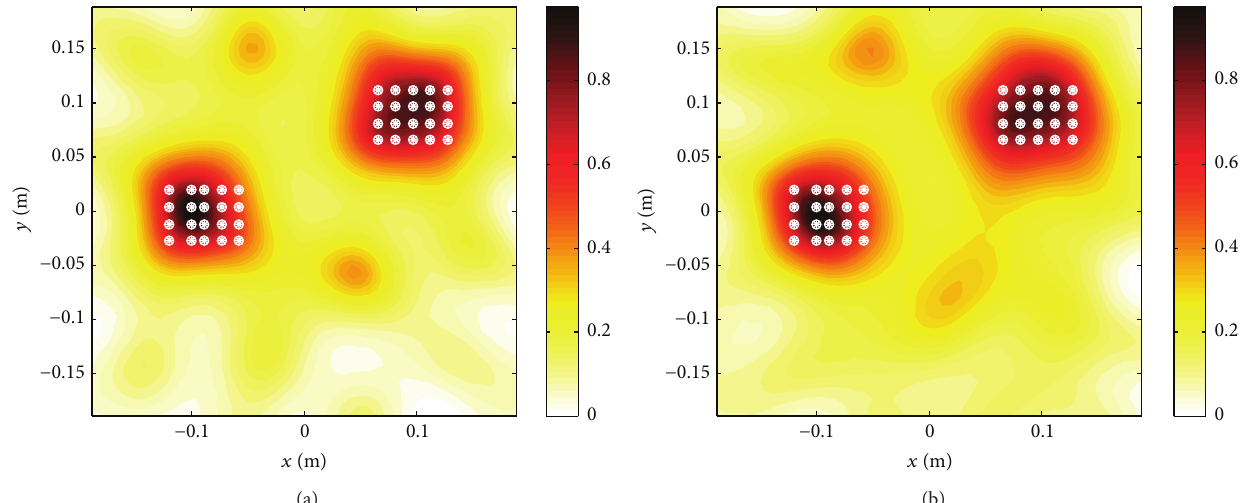
Figure 5: Example 1: LSM reconstructions by using measurement configuration B and corresponding pivot points. (a) Square scanner and (b) triangular scanner.